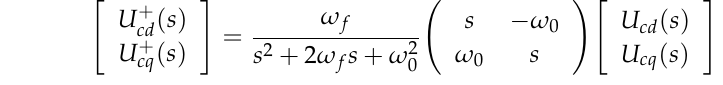
Figure 5. Control block of DDSRF-PLL.